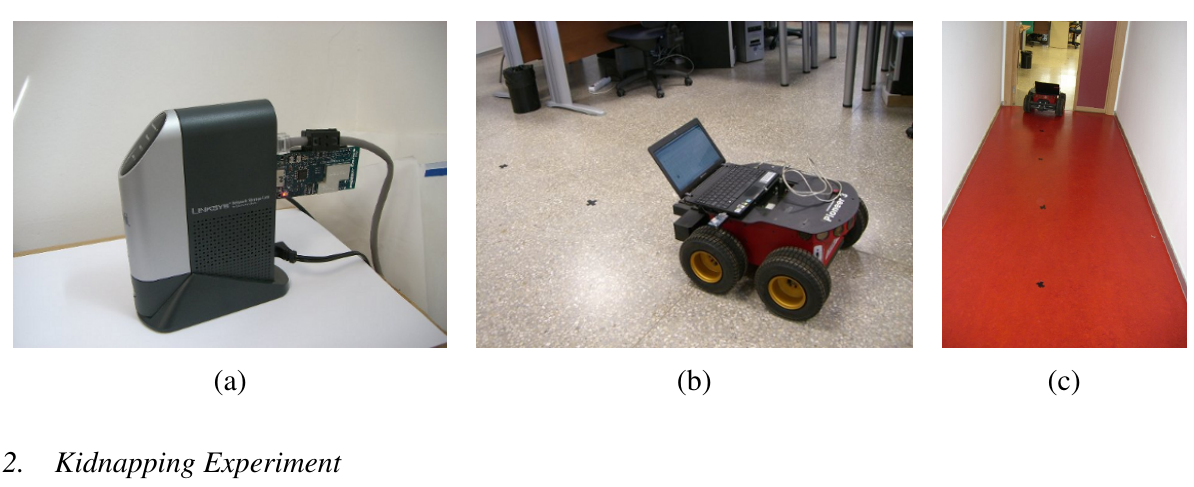
Figure 7. Experimental setup: (a) WSN beacon installed in a NAS device, (b) mobile robotic platform, and (c) the robot performing a tracking